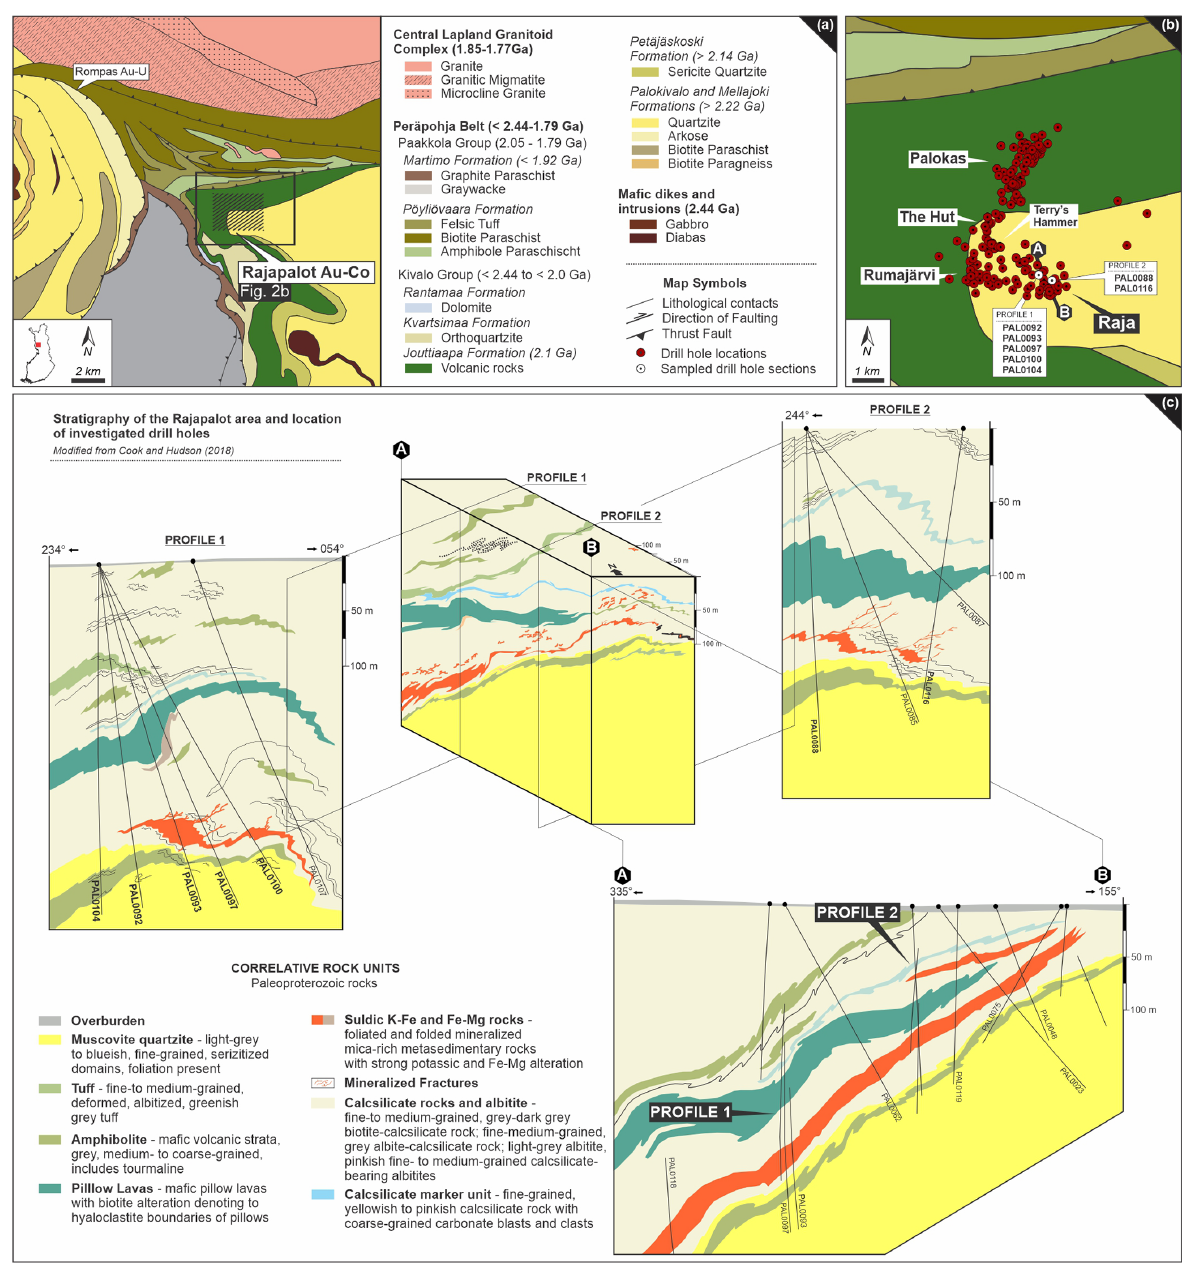
Figure 2. (a) Detailed geologic map showing the location of the Rajapalot Au–Co area. (b) Drill hole location map of Rajapalot and its major prospects and location of investigated drill holes within the Raja area (indicated as white circles). Maps (a) and (b) are based on DigiKP, the digital map database of the Geological Survey of Finland. A–B cross section shown in (c) . Block model of the corresponding A–B cross section from (b) showing the stratigraphy of the Raja prospect area and location of sampled drill holes included in profile 1 and profile 2. Corresponding NE–SW profiles from profile 1 and location of sampled drill holes: PAL0104, PAL0092, PAL0093, PAL0097 and PAL0100, as well as drill holes from profile 2 (PAL0088 and PAL0116). Block model and profile sections drawn by Jackson van den Hove (PGN Consulting) and are modified from Cook and Hudson